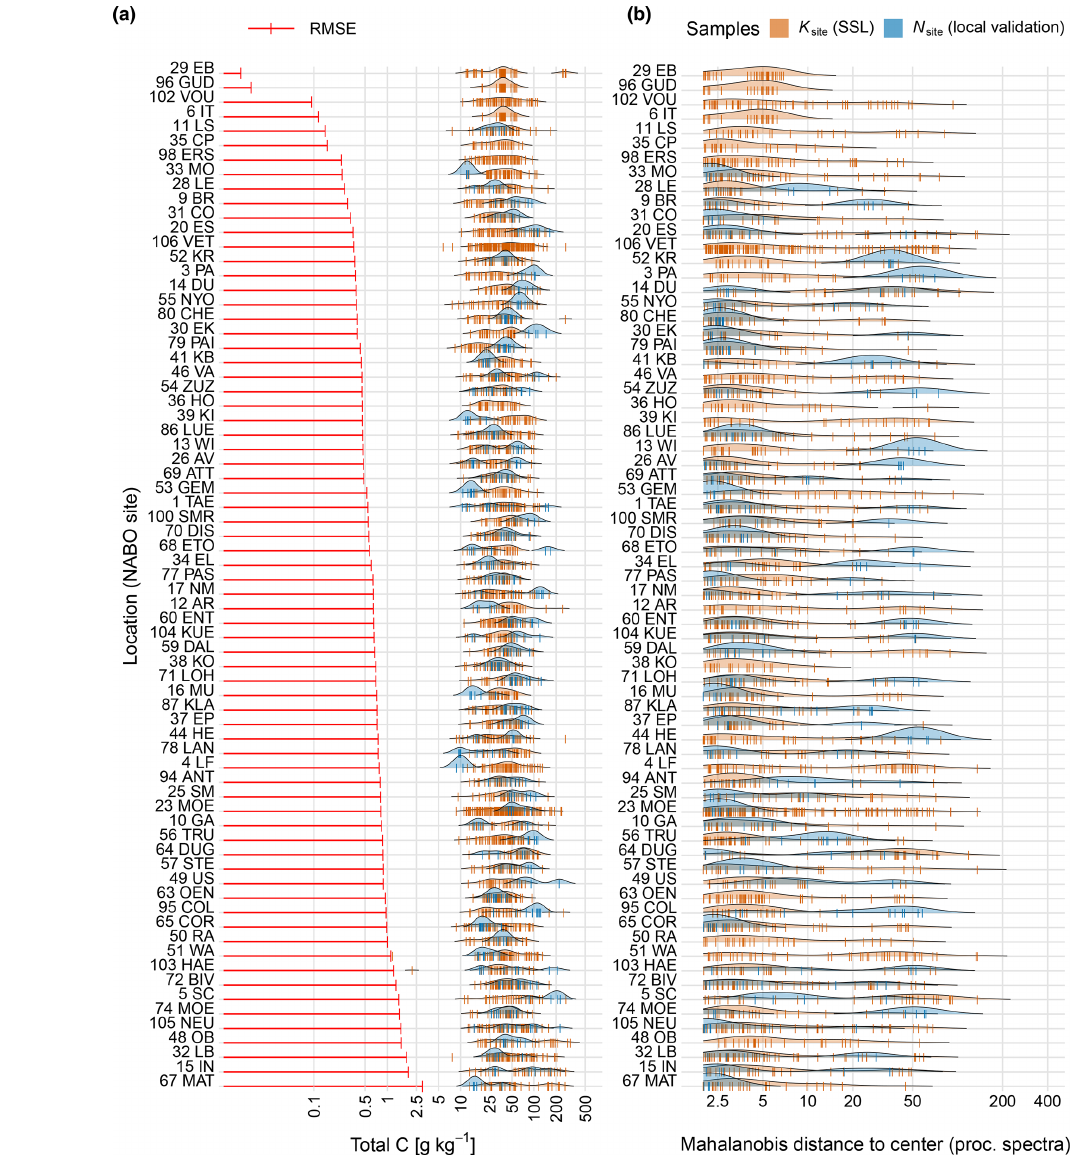
Figure 7. Analyzing the mechanisms behind the individual adaptive transfer realized with RS-LOCAL . (a) The left horizontal bars show the root mean square error (RMSE) of mid-IR predictions of the temporal validation set N site of time series of total carbon (C) for each of the 71 NABO sites, which was calculated without the two respective calibration samples. The blue density plots depict the distribution of the site-specific validation samples, and the brown vertical bars show the measured values of C for the final subsets of SSL used for the transfer ( K site ). (b) The distribution of the robust distances from the PCA center of the Savitzky–Golay preprocessed spectra of the entire soil spectral library compared to the subset of instances involved in the individual transfer modeling ( K site ) and validation samples ( N site ; similarity in site-specific vs. final RS-LOCAL selection) computed with the minimum covariance determinant (MCD)